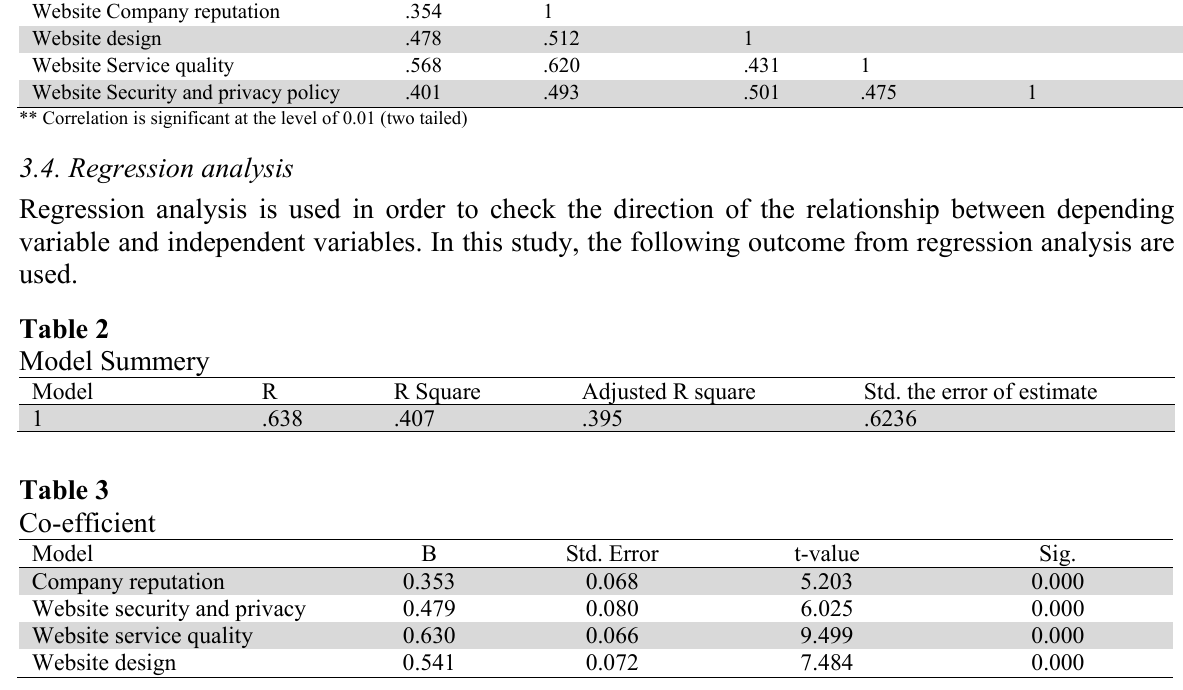
An online Website Company reputation